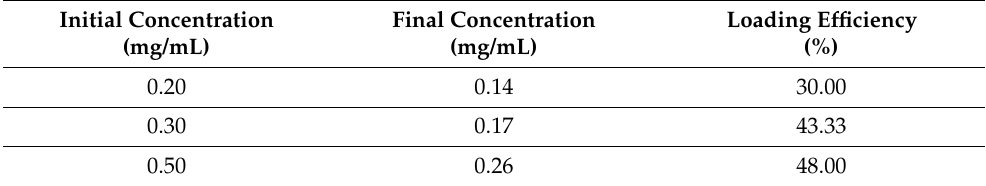
Table 4. Loading efficiency (%) of CS-Tb 2 S 3 NPs onto contact lens